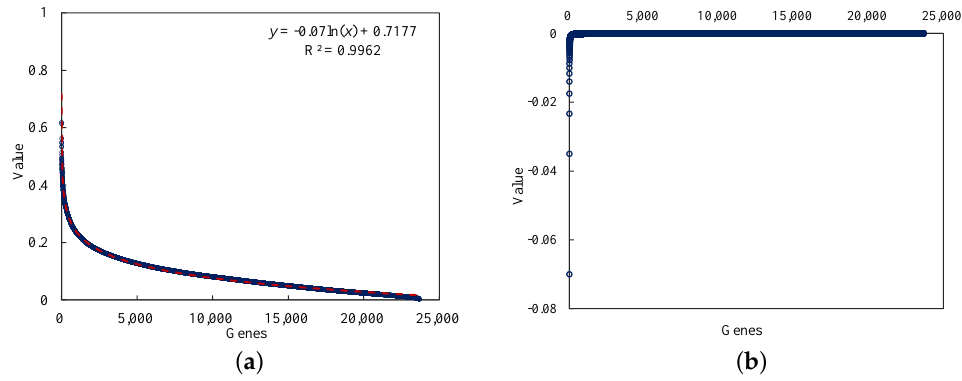
Figure 2. The results of gene selection step. ( a ) Mutual information values. The calculated values of all other remaining genes and driver genes, which, in function y , is the fitting curve equation, and R 2 is the coefficient of determination, meaning the higher the fitting degree, the closer to 1. ( b ) Threshold. All values are derived based on the obtained fitting curve function y in ( a ) and sorted according to the resulting values.